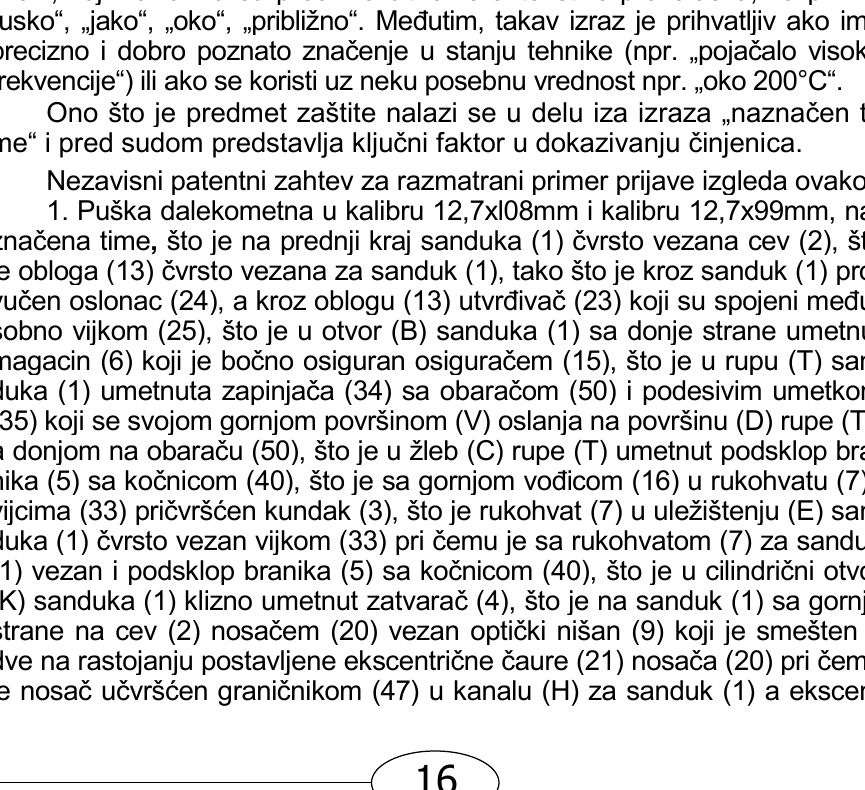
(1) vezan i podsklop branika (5) sa ko č nicom (40), što je u cilindri č ni otvor (K) sanduka (1) klizno umetnut zatvara č (4), što je na sanduk (1) sa